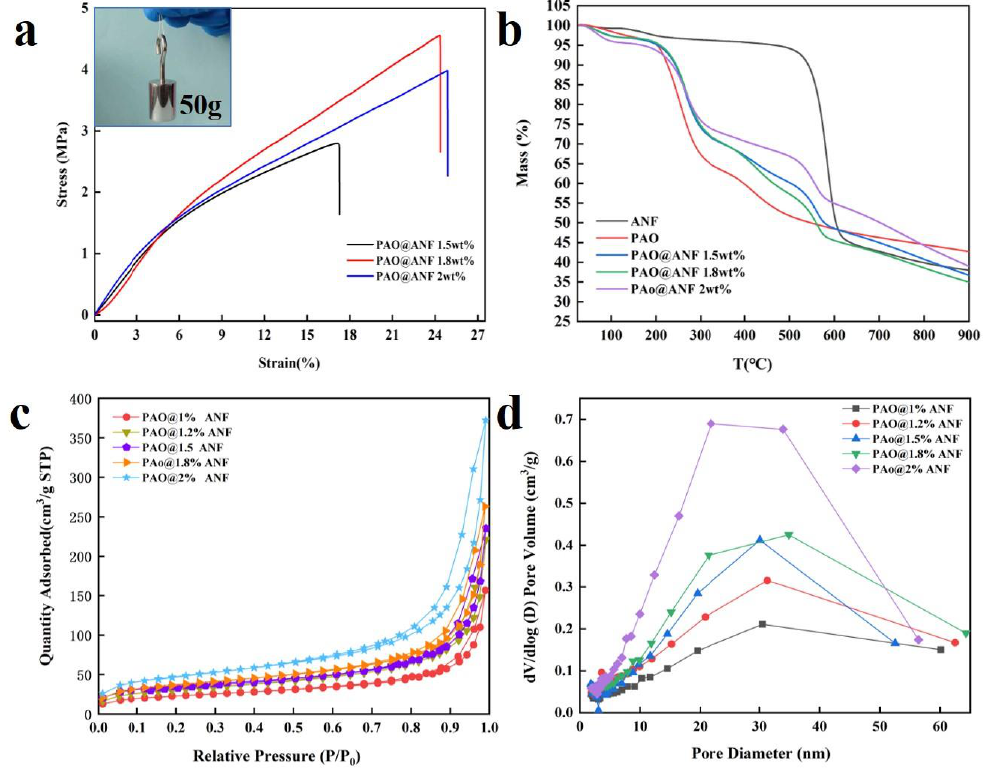
Figure 3. ( a ) The stress – strain curves of the PAO@ANF aerogel fibers formed in ANF solution with concentration from 1.5 – 2.0 wt.%, inset in e is the photo image of the PAO@ANF aerogel fiber bearing a 50 g weight. ( b ) TGA curves of ANF, PAO, and PAO@ANF aerogel fibers. ( c ) N 2 adsorption – desorption isotherms and ( d ) pore size distribution curves of the PAO@ANF aerogel fibers.